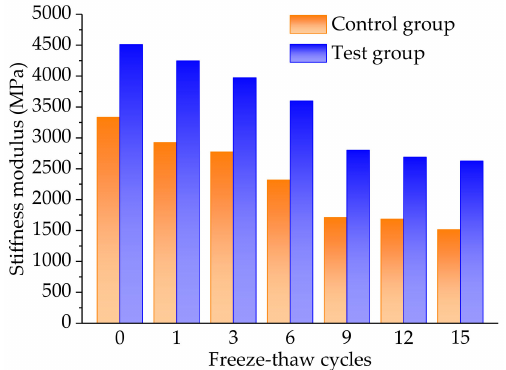
Figure 13. Comparative results of the indirect tensile stiffness modulus of the control and the test groups, under different freeze-thaw